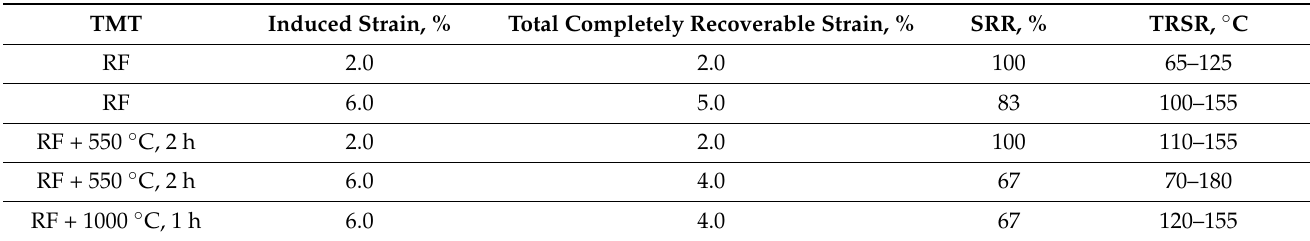
Table 7. Total completely recoverable strain and TRSR of TiNiHf rods after RF, RF + PDA at 550 ◦ C for 2 h, and RF + PDA at 1000 ◦ C for 1